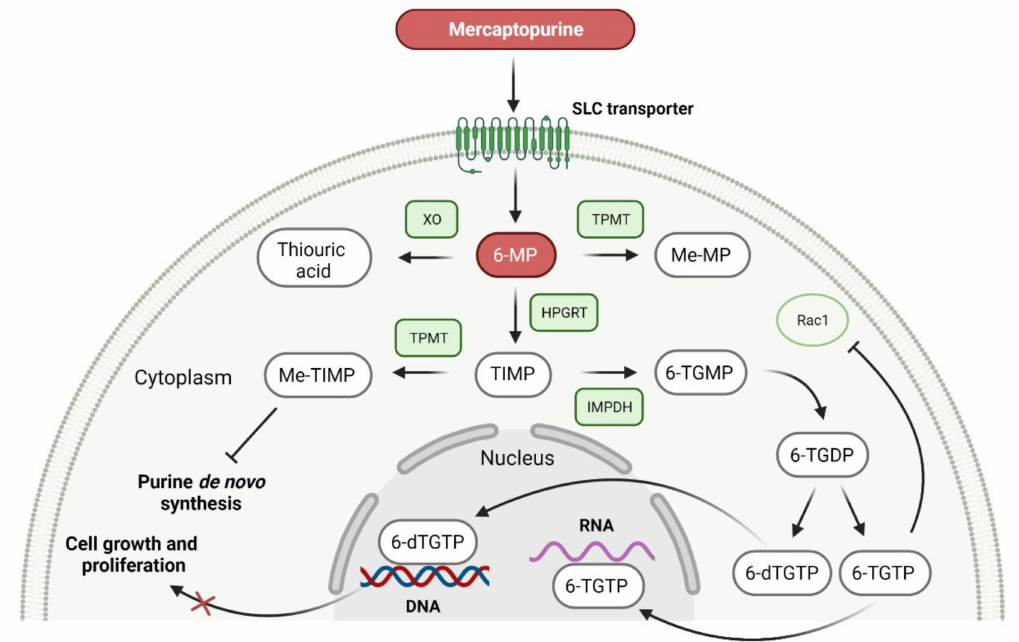
Figure 8. Scheme of metabolism and mode of action of mercaptopurine (6-MP). SLC : solute car- rier. 6-MP : mercaptopurine. XO : xanthine oxidase. TPMT : thiopurine methyltransferase. Me-MP : methylmercaptopurine. HPGRT : hypoxanthine-guanine phosphoribosyltransferase. TIMP : thioino- sine monophosphate. Me-TIMP: methyl thioinosine monophosphate. IMPDH : inosine monophos- phate dehydrogenase. 6-TGMP : 6-thioguanosine monophosphate. 6-TGDP : 6-thioguanosine diphos- phate. 6-dTGTP : deoxy-6-thioguanine triphosphate. 6-TGTP : 6-thioguanosine triphosphate. Rac1 : ras-related C3 botulinum toxin substrate 1. DNA : deoxyribonucleic acid. RNA : ribonucleic acid. Created with BioRender.com based on information in